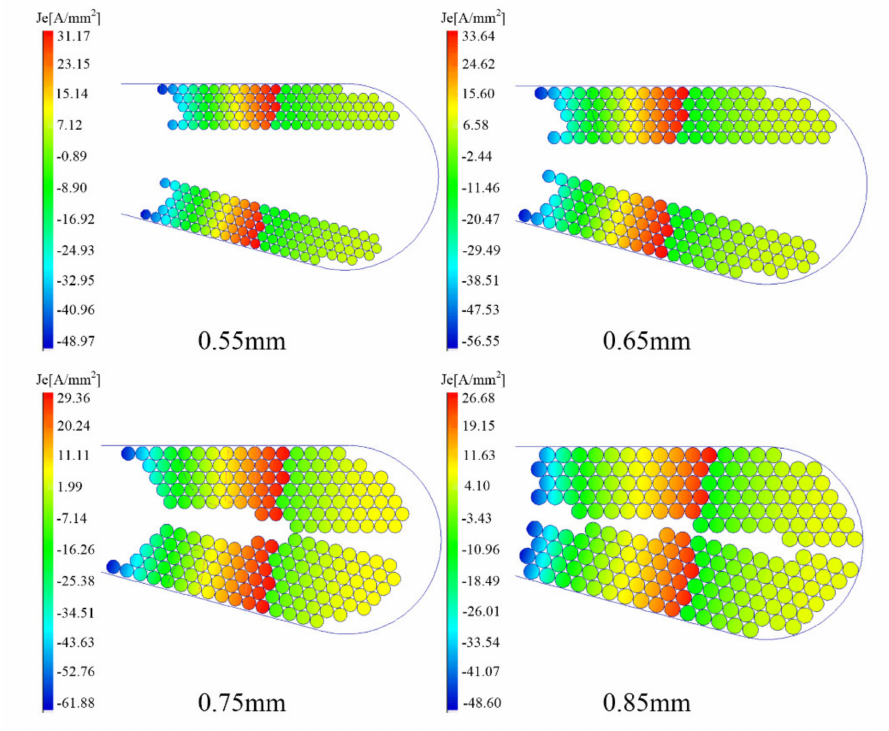
Figure 6. Current density distribution with different conductor diameters at 1000 Hz for Case